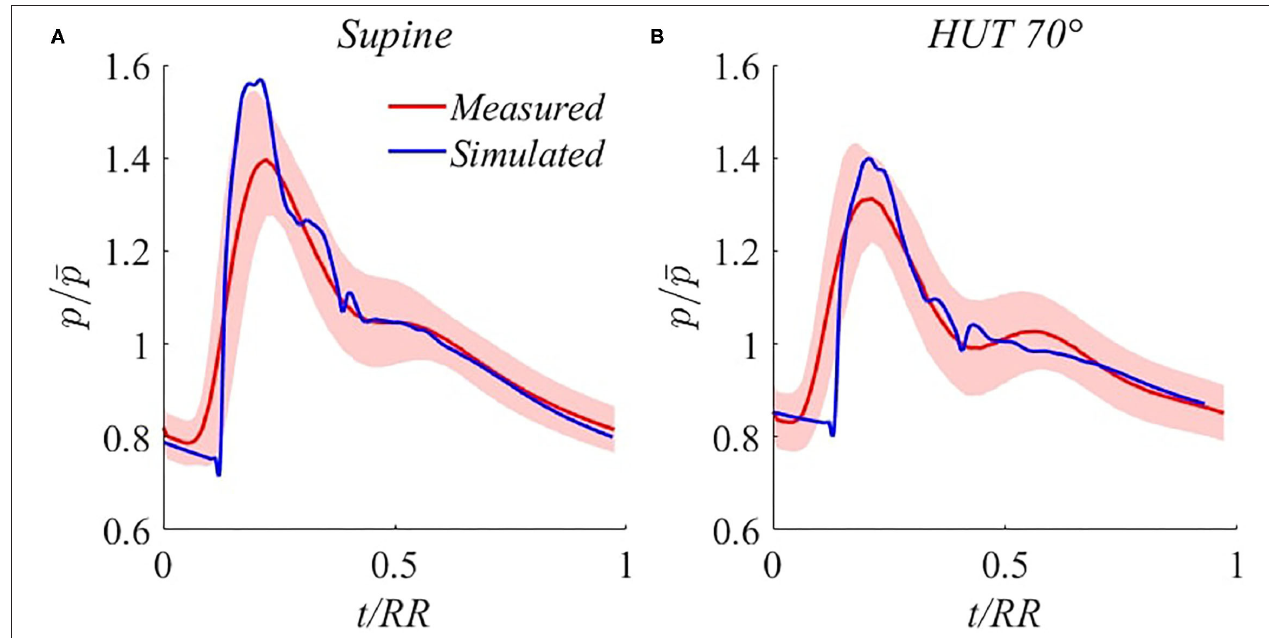
FIGURE 3 | Comparison between simulated (blue) and measured (red, with SD bands) steady-state brachial pressure waveforms for supine (A) and 70 ◦ HUT (B) . ¯ p denotes brachial MAP